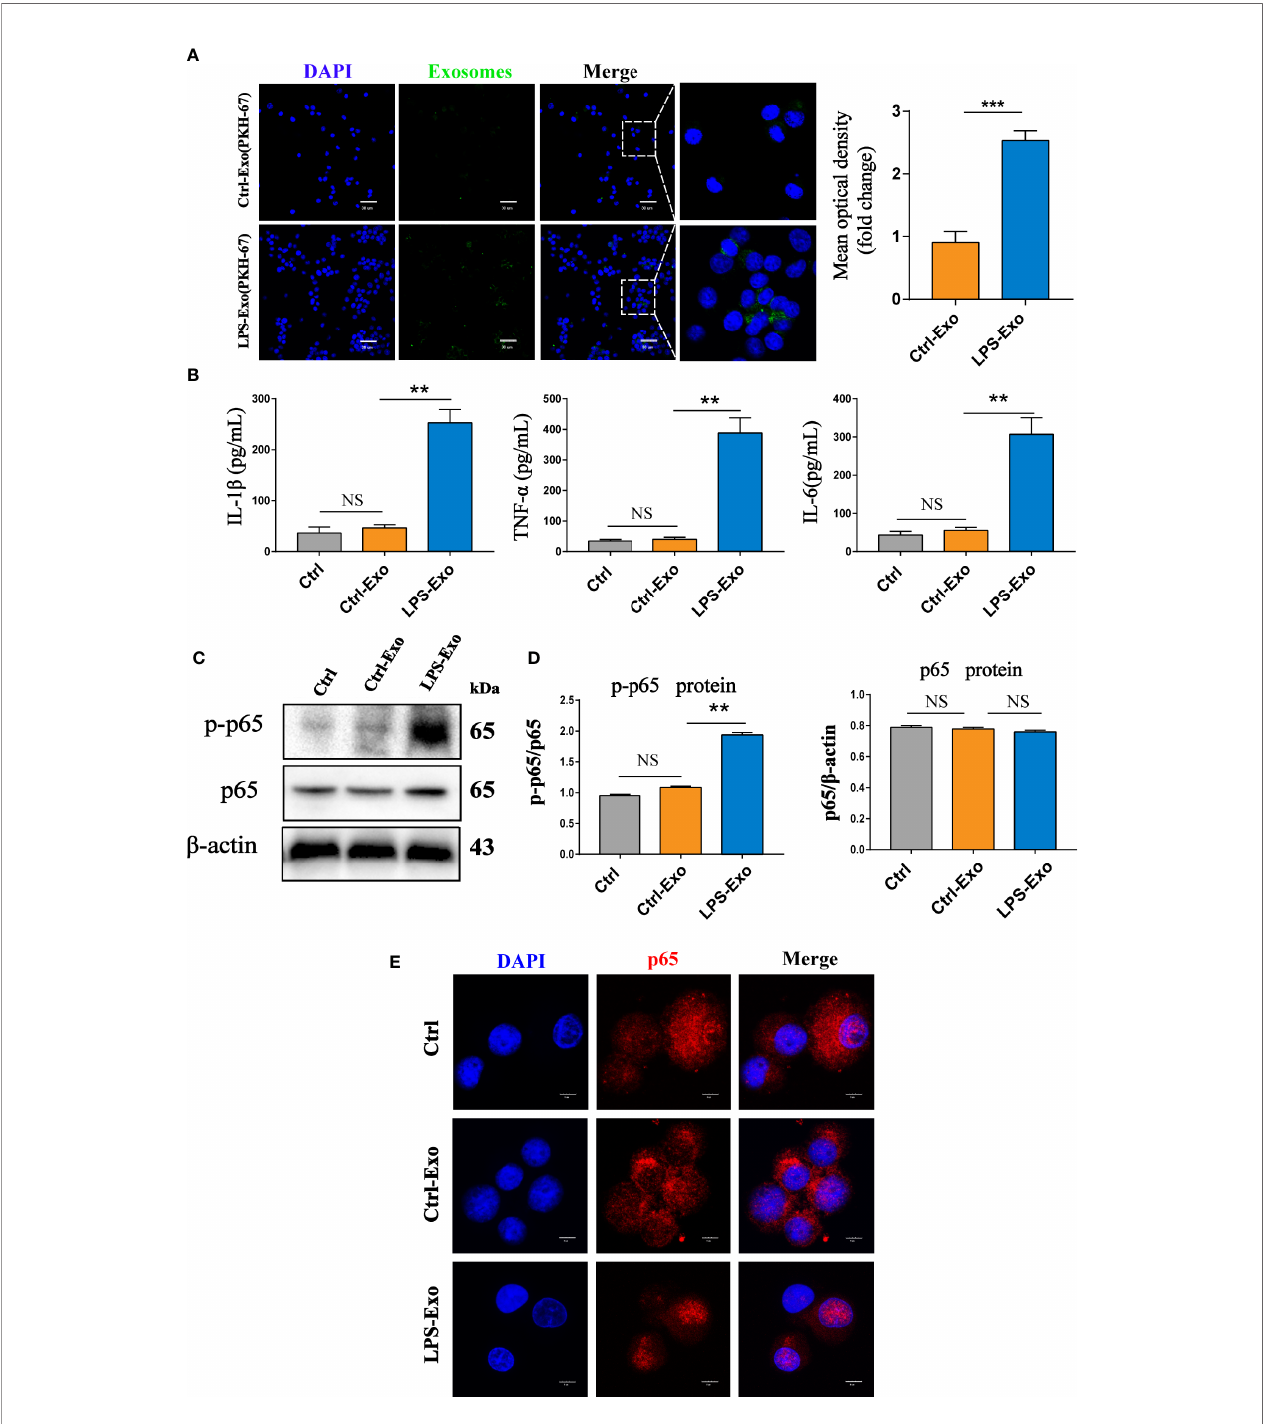
FIGURE 3 | Internalized LPS-treated AECs promote AM activation. (A) PKH-67 labelled AEC exosomes were cocultured with recipient AMs for 12 h. Relative fl uorescence intensity was quanti fi ed to identify the internalization of exosomes. Scale bar, 30 m m. (B) Proin fl ammatory cytokine IL-1 b , TNF- a and IL-6 levels in the supernatant of the AMs treated with AEC exosomes for 12 h. (C, D) Representative western blot and quantitative analysis of p-p65 and p65 in recipient AMs treated with AEC-derived exosomes with or without LPS stimulation. (E) Representative images of the nuclear translocation of p65, as observed by immuno fl uorescence assays. Immuno fl uorescence staining of p65 (red) and nuclei (blue) at 12 h following AMs were treated with LPS-Exos or Ctrl-Exos. Scale bar, 5 m m. Data are presented as the mean ± S.E.M. **P<0.01, ***P<0.001 compared between two groups. NS, no signi fi cant difference. n=3 per